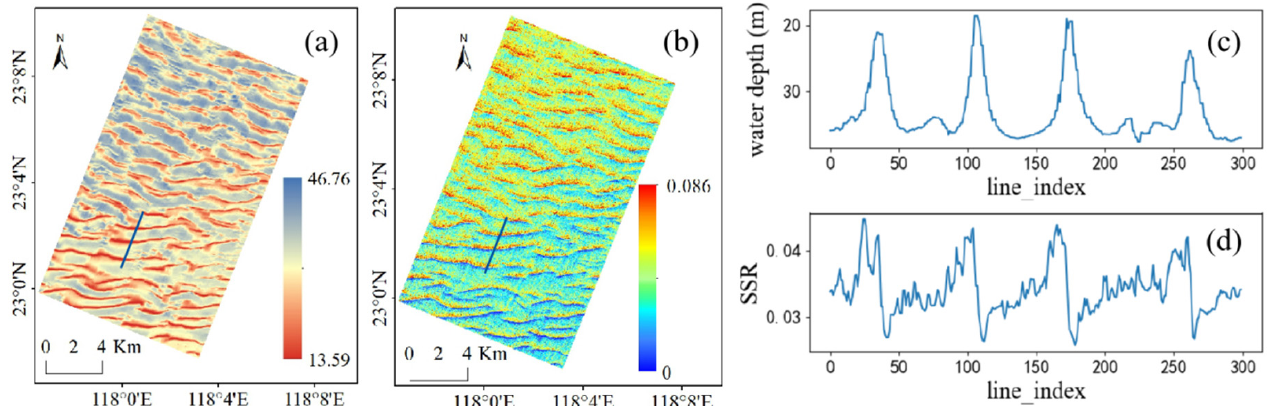
Figure 3. ( a ) Water depth in area A1 obtained by interpolating with 500 m interval bathymetric lines, ( b ) roughness in area A1, ( c ) variations in water depth on the profile line, ( d ) variations in SSR on the profile line.